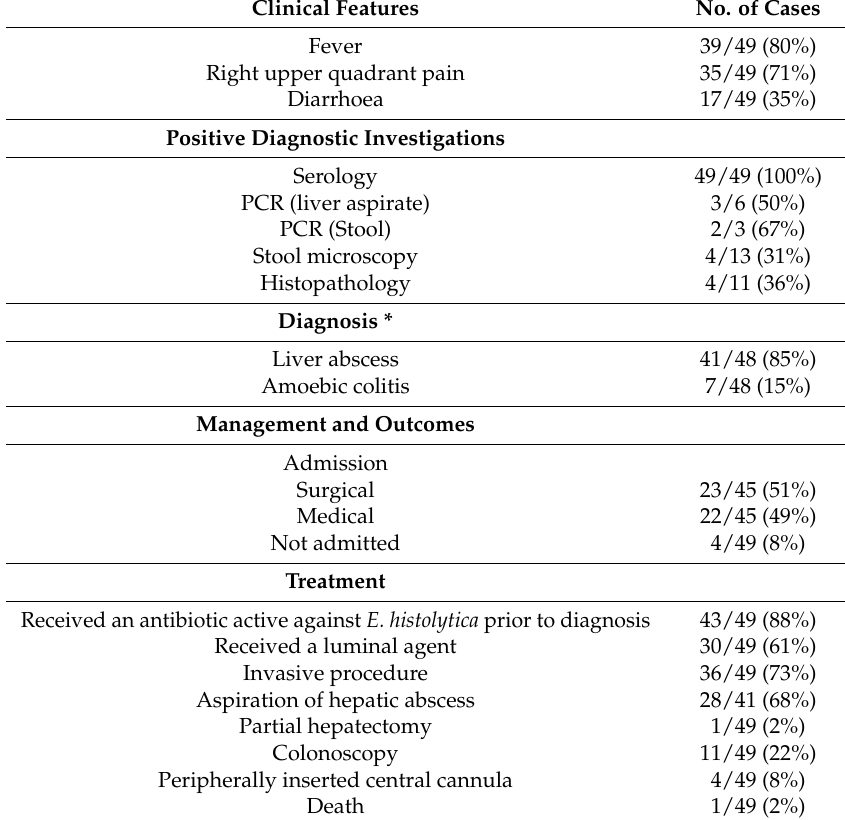
Table 2. Clinical features, diagnostic testing, management, and outcome data of patients with invasive amoebiasis managed at Western Sydney Local Health District between 2005 and